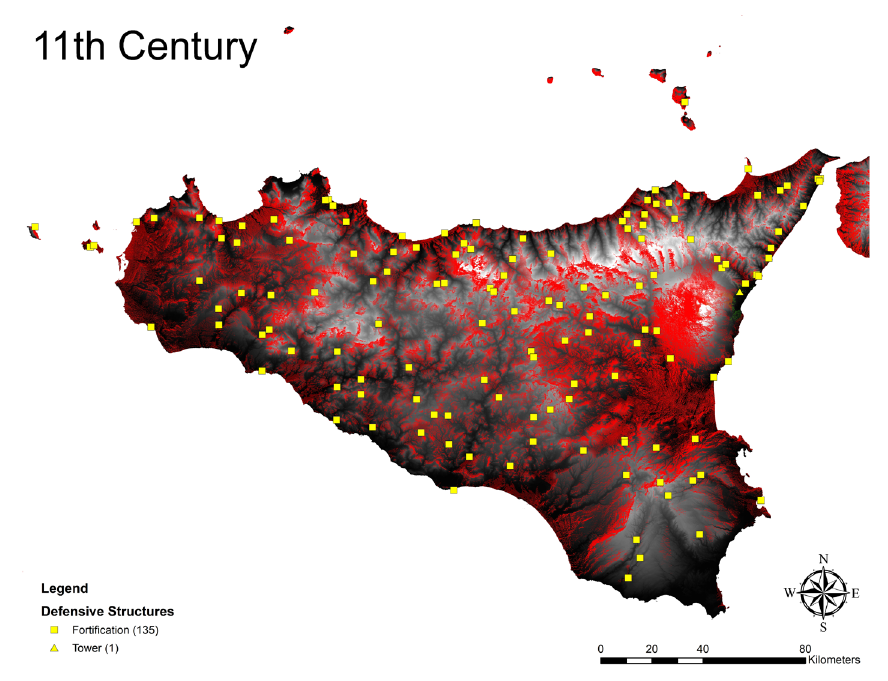
Figure 2. Figure showing the distribution of defensive structures and their viewsheds in the 11th century. Fortifications are represented by squares and the area they have surveillance over is in red whereas towers are represented by triangles and the area they have surveillance over is in green. Image derived from an ASTER GDEM (a product of NASA and METI).